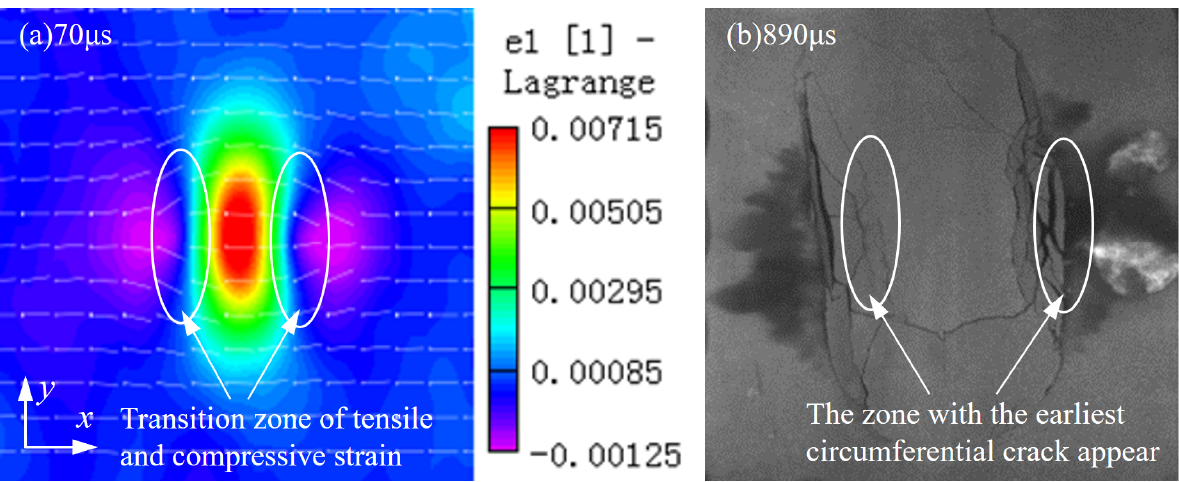
Figure 10. Maximum principal strain field and the crack network. ( a ) The maximum principal strain field under an SSR of 0.42 after 70 μs of explosion; ( b ) the crack network under an SSR of 0.4 after 890 μs of explosion.